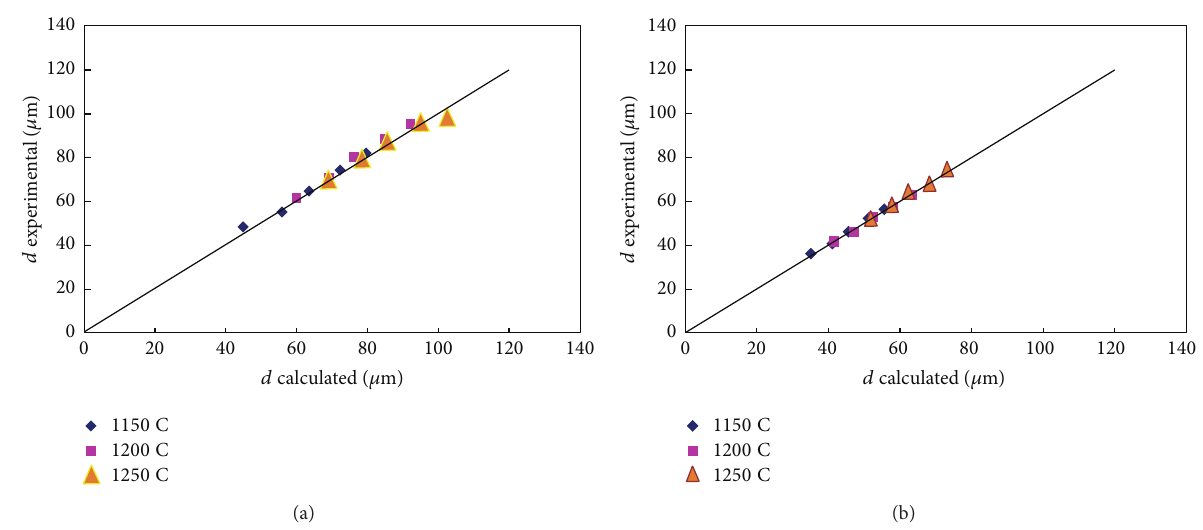
Figure 7: Relation between experimental and calculated grain size values of (a) X65 and (b)